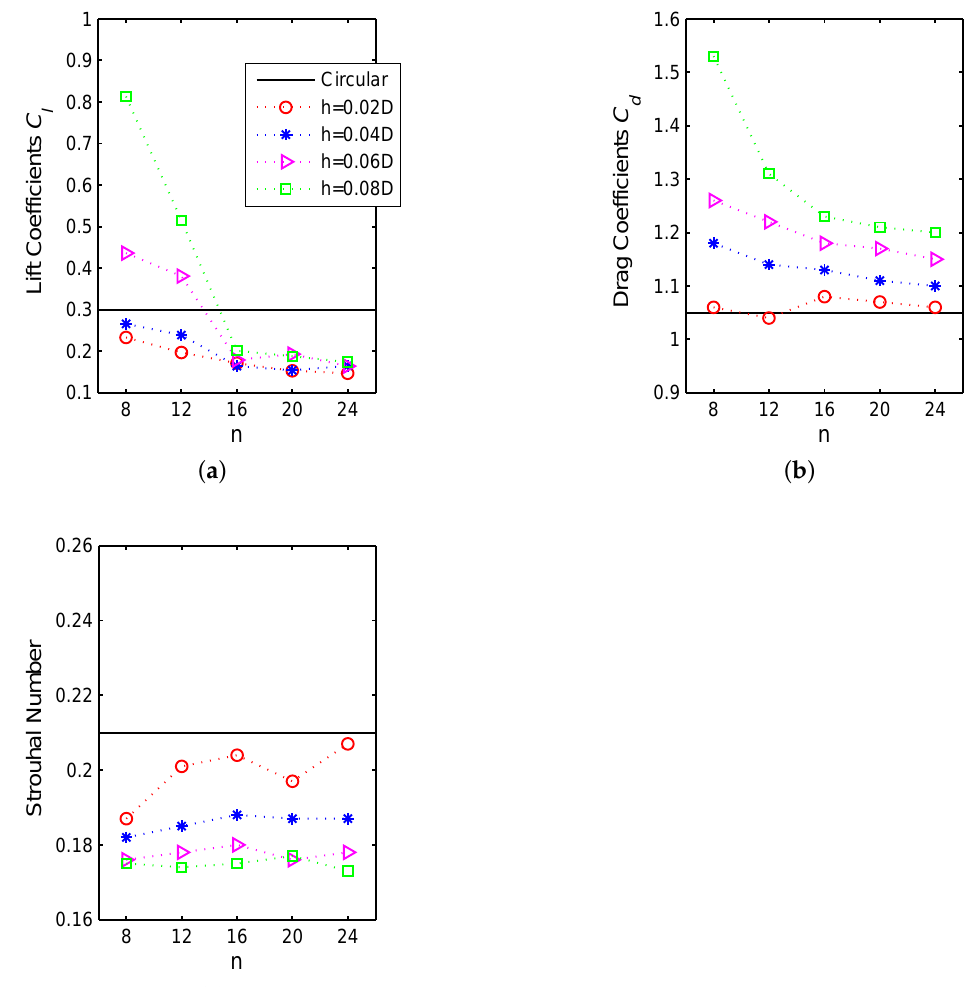
cylinder, R 8-0.04, and the lower figure is for the circular cylinder, R 0. Compared to